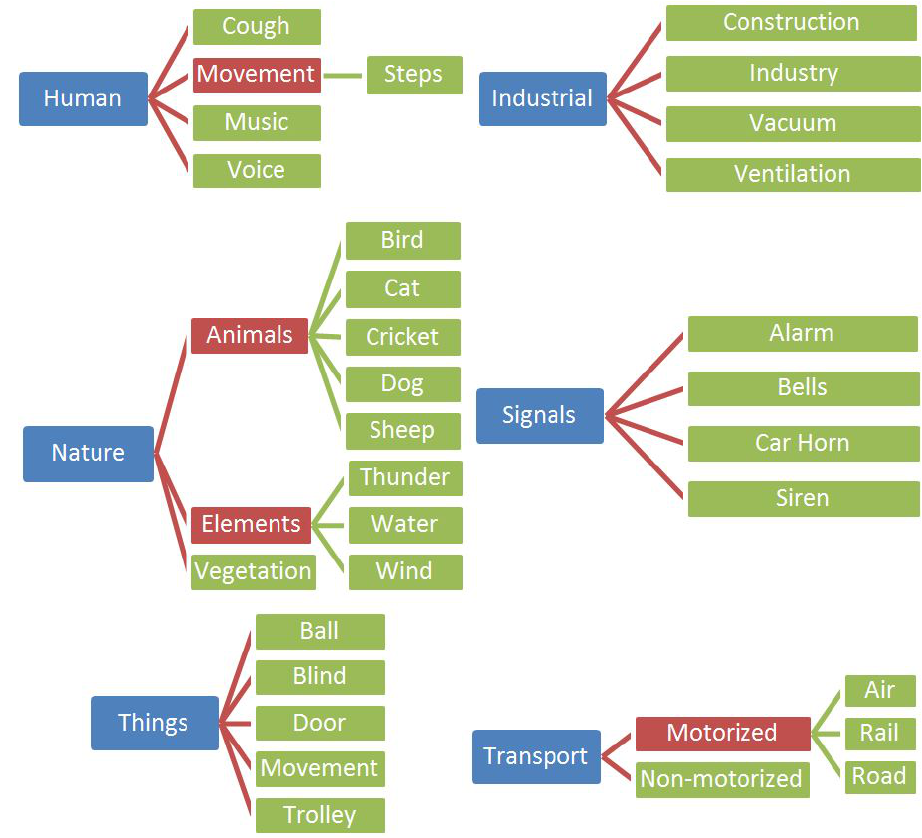
Figure 2. Sound Elements Hierarchical